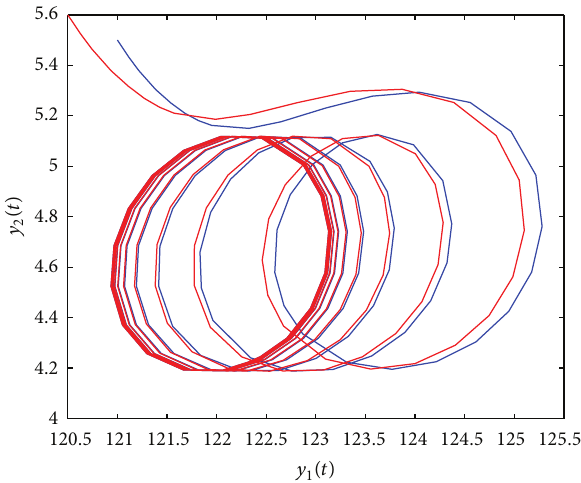
Figure 3: The unique positive 2𝜋 -periodic globally stable solution, which is plotted in the 𝑦 1 - 𝑦 2 plane. Two different initial solutions are included to show the attractivity of different solutions, which are plotted in red and blue color,